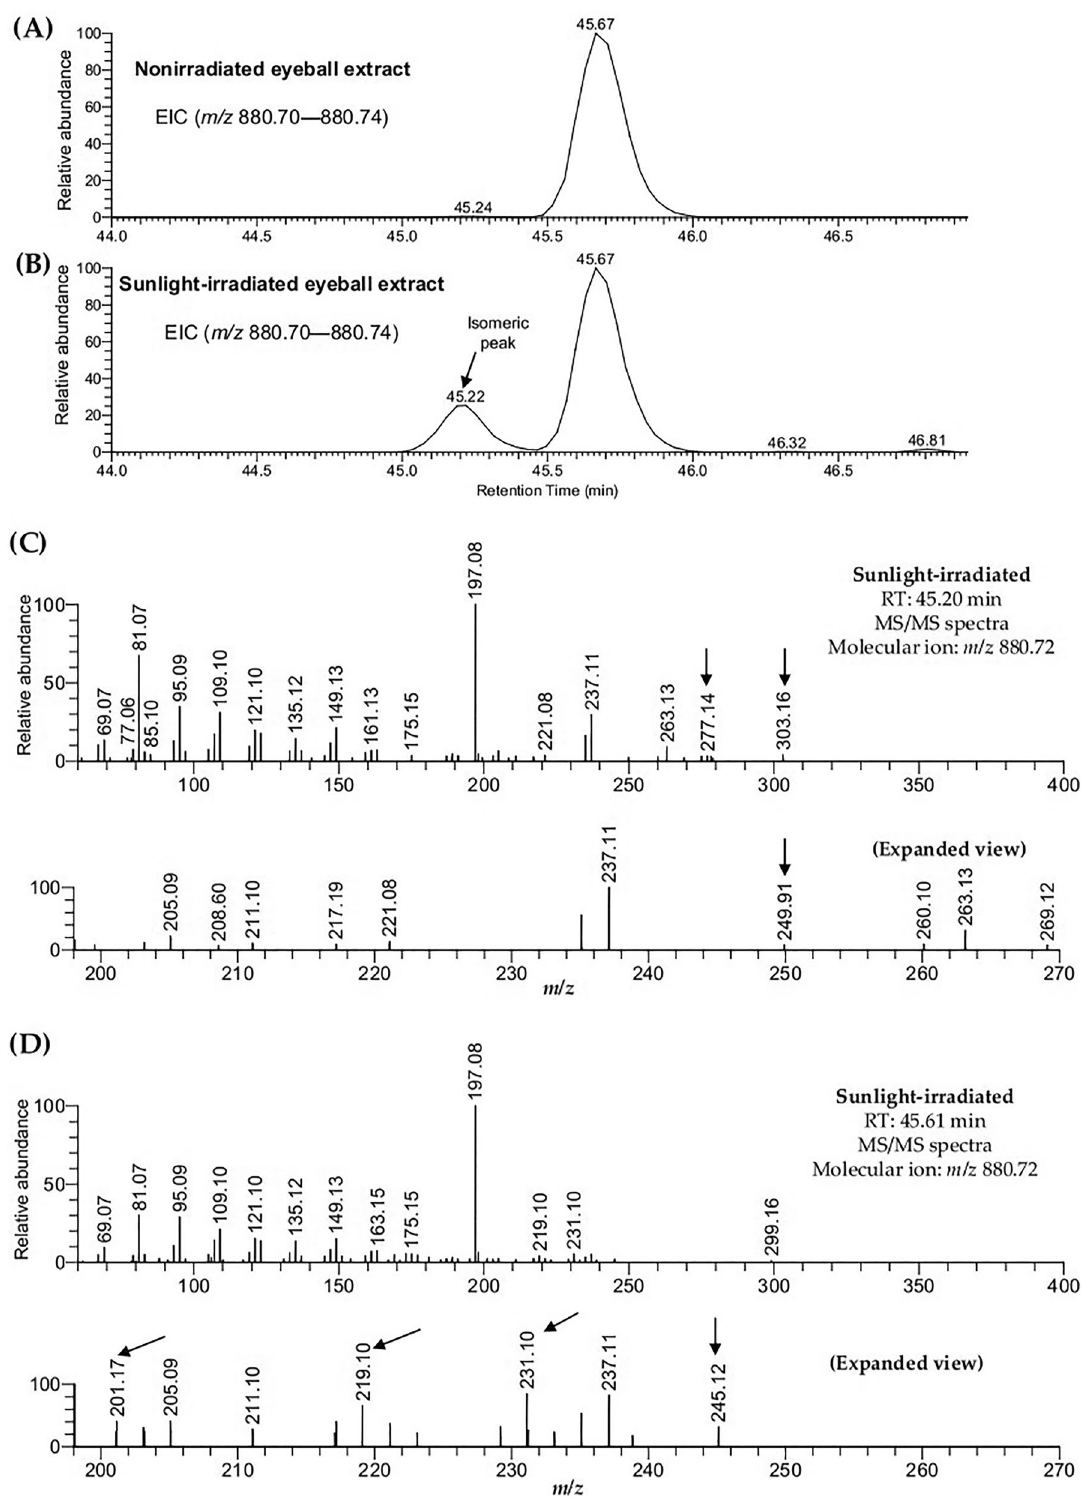
Figure 3. EIC and MS/MS spectra of coenzyme Q10 (CoQ10) in sunlight-irradiated eyeball extract. The EICs were observed in the ( A ) nonirradiated and ( B ) irradiated extract. MS/MS spectra of CoQ10 at ( C ) RT 45.20 min and ( D ) RT 45.61 min in the irradiated extract. Arrows indicate the fragmentations exclusively observed at RT 45.20 min or RT 45.61